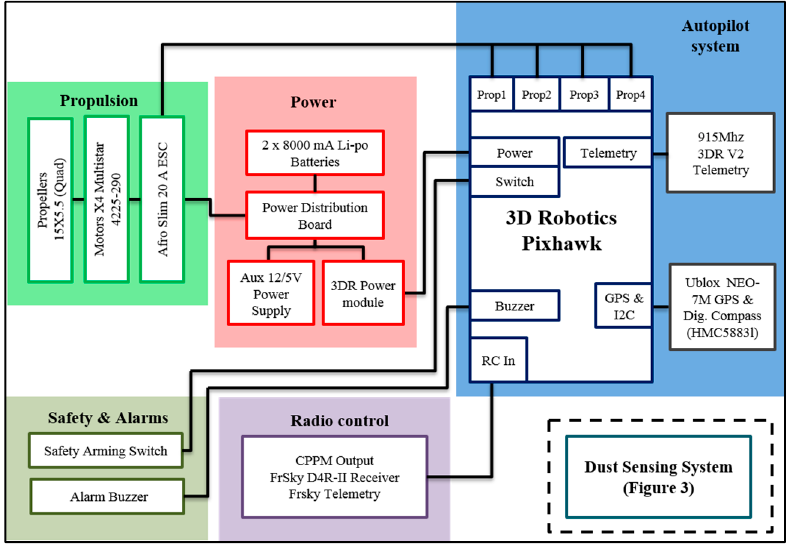
Figure 2. System architecture for quadcopter UAV with independent gas-sensing